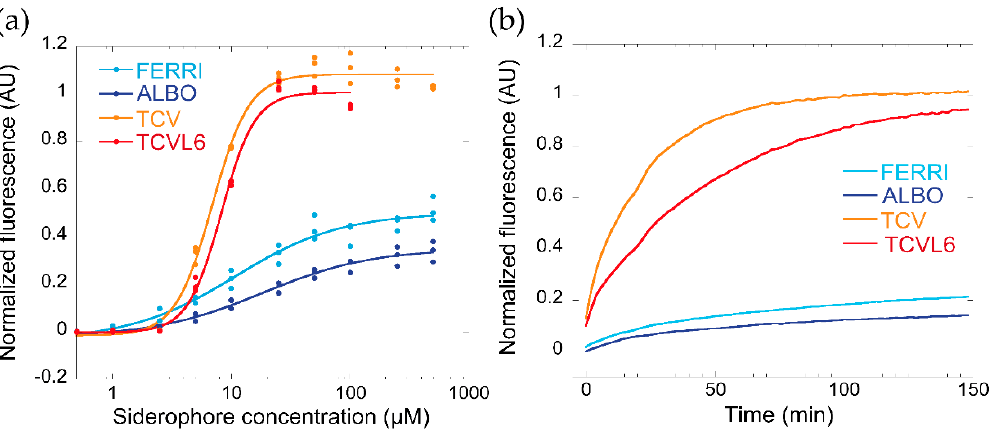
Figure 2. ( a ) Ability of FERRI, ALBO, TCV, and TCVL6 to scavenge iron from PVD-Fe complexes. Ten micromoles of PVD-Fe in 100 mM HEPES pH 7.4 were incubated with increasing concentrations of FERRI, ALBO, TCV, or TCVL6 for 48 h (until equilibrium was reached), as described previously [16]. Metal-free PVD is fluorescent, with absorbance typically at 447 nm, and PVD-Fe is not [33]. Apo PVD formation was thus followed by monitoring its fluorescence at 447 nm (excitation at 400 nm). The data were normalized using the formula (F MEASURED— F PVD-Fe )/(F PVD —F PVD-Fe ), F MEASURED being the fluorescence measured for each experimental condition, F PVD-Fe the fluorescence of 10 µM PVD-Fe, and F PVD the fluorescence of 10 µM PVD. ( b ) Kinetics of PVD-Fe dissociation in the presence of FERRI, ALBO, TCV, or TCVL6. Ten micromoles of PVD-Fe in 100 mM HEPES buffer pH 7.4 was incubated with 100 µM FERRI, ALBO, TCV, or TCVL6, as described in Materials and Methods. The kinetics of apo PVD formation were followed by monitoring the fluorescence emission at 447 nm (excitation at 400 nm), as previously described [16].